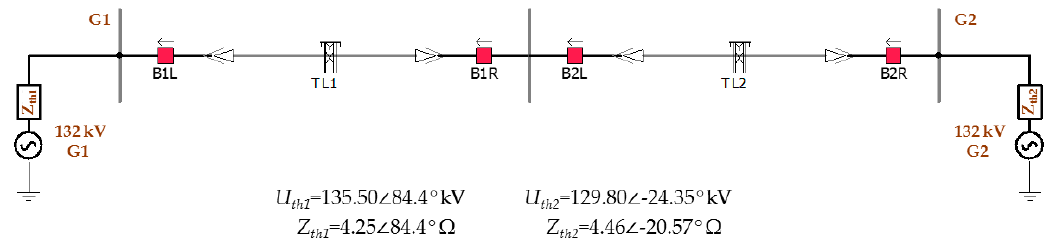
Figure 3. Modeled power system.